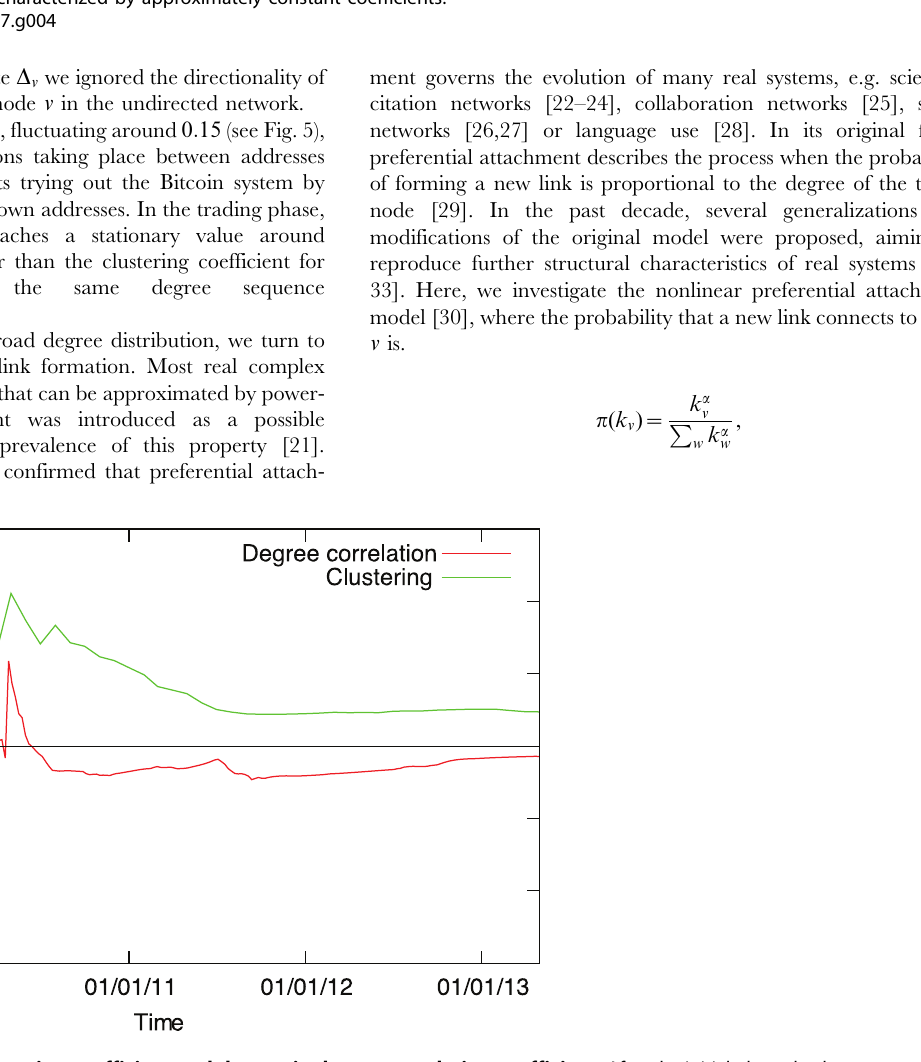
Figure 5. Evolution of the clustering coefficient and the out-in degree correlation coefficient. After the initial phase, both measures reach a stationary